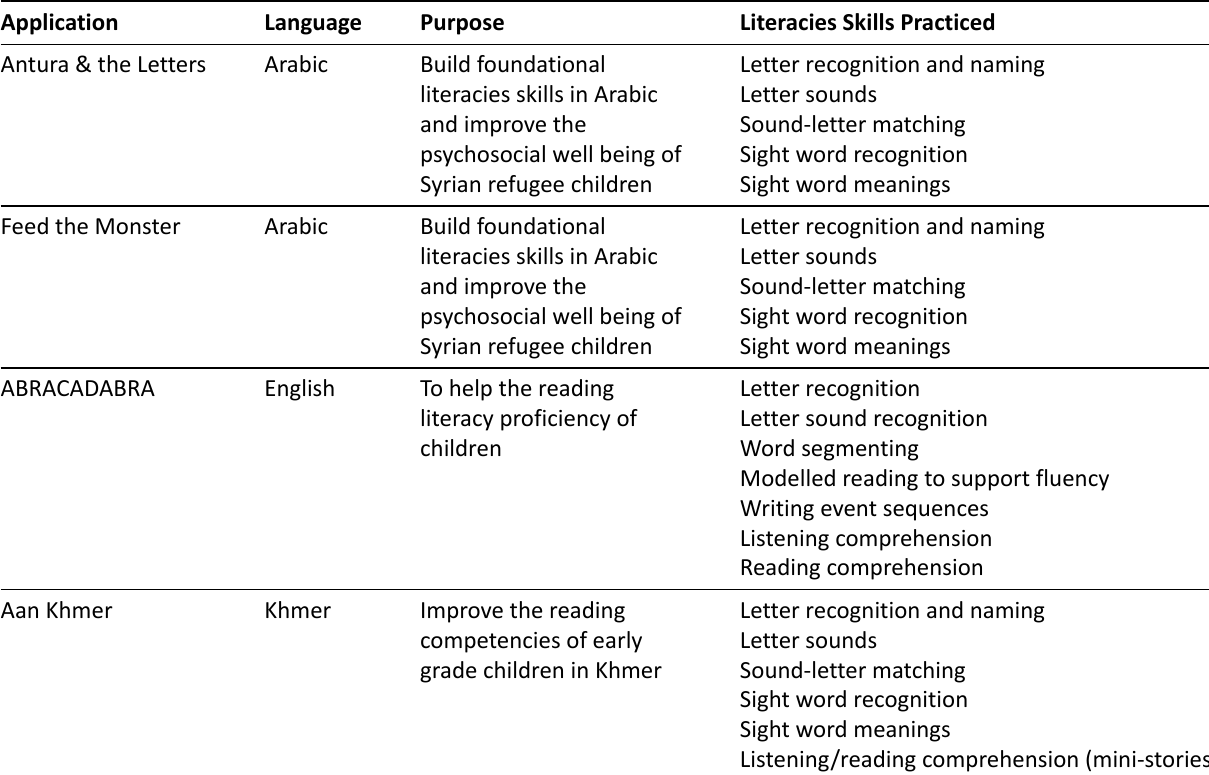
Table 2. Summary of fixed design applications, their purposes and emergent literacies skills